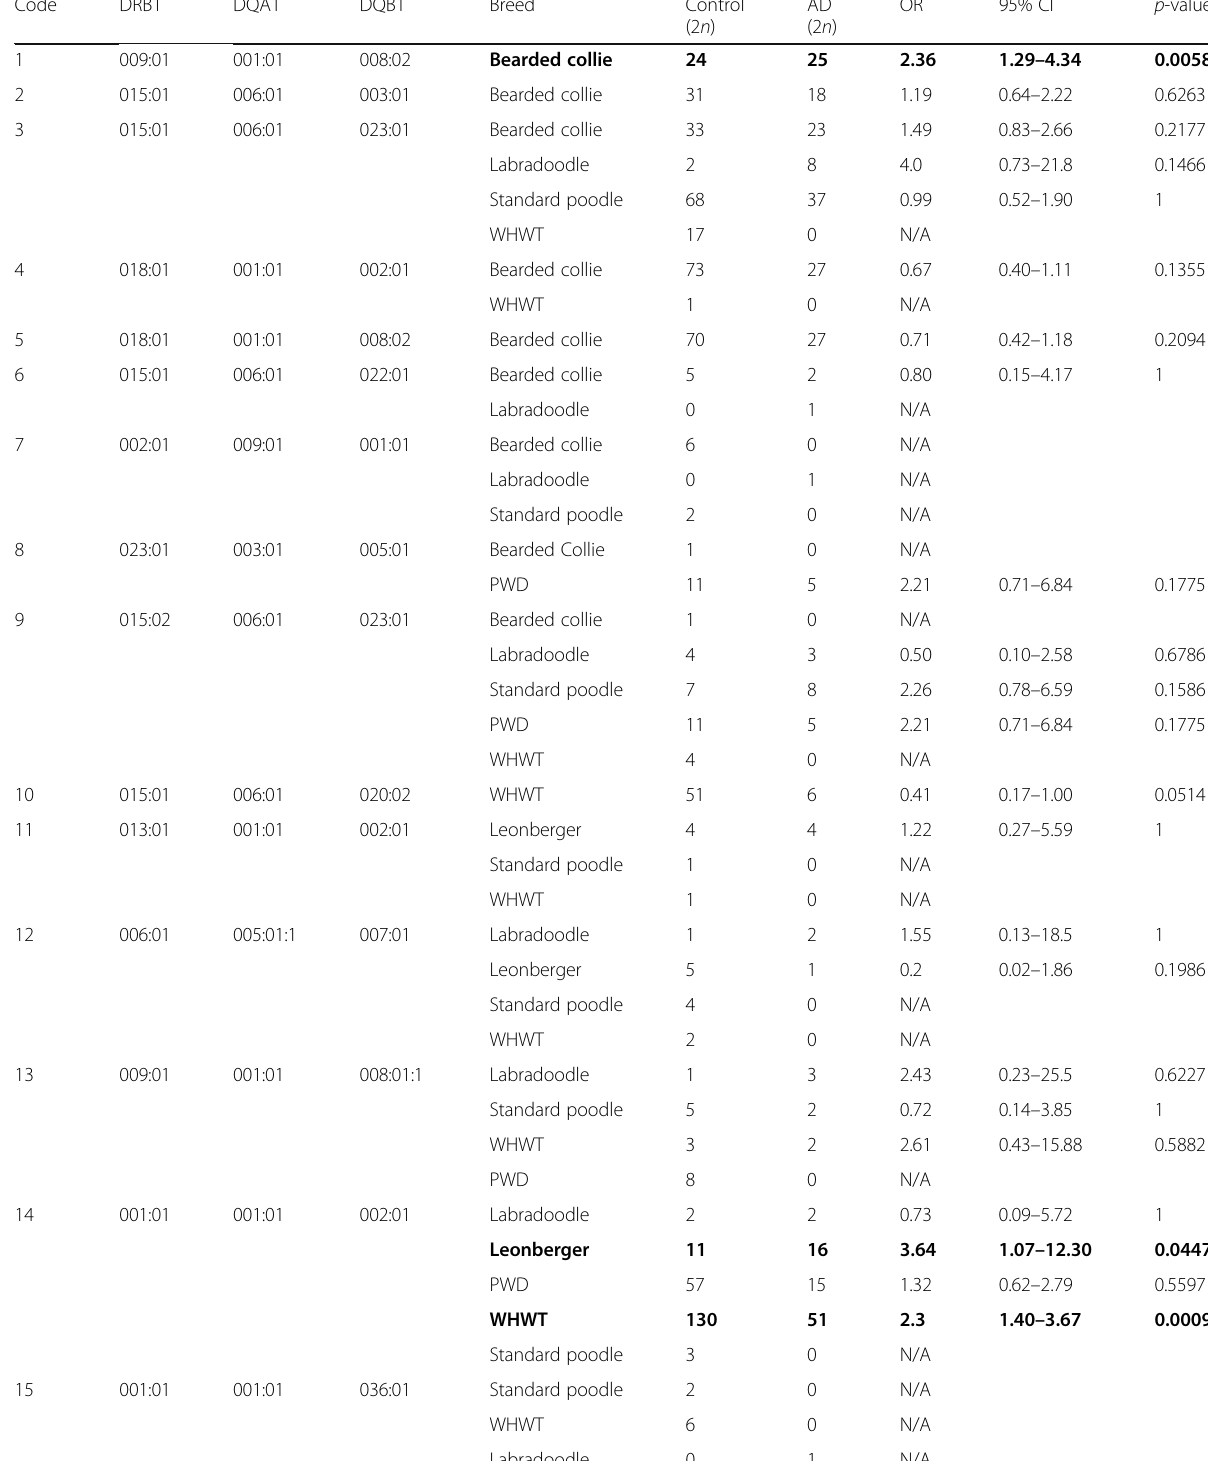
Table 5 Frequency, code and odds ratio (OR) for DLA class II three-locus haplotypes observed in the six studied breeds at increased risk for Addison ’ s disease (AD): bearded collie (61 cases, 122 controls), West Highland white terrier (WHWT; 43 cases, 166